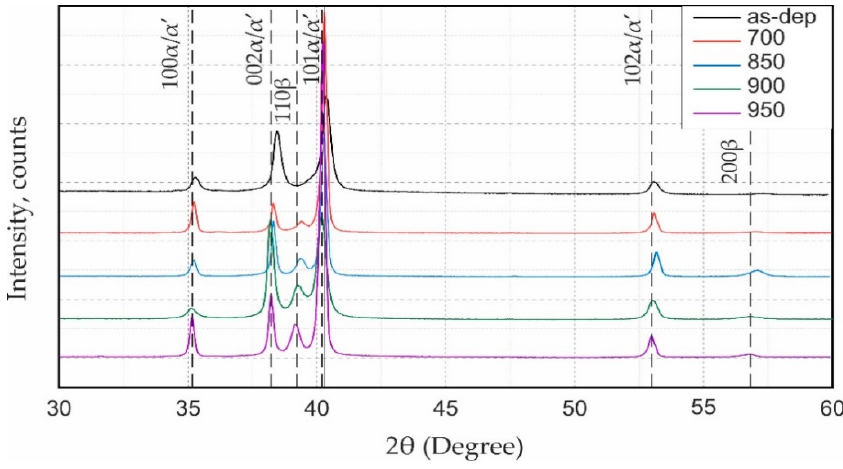
Figure 6. XRD patterns of as-deposited Ti-6Al-4V alloy and after heat treatment.